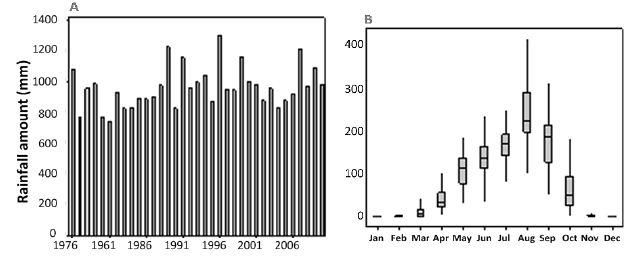
Fig. 2 . Annual rainfall (A) and monthly variation in rainfall (B) of Bolgatanga (1976-2010). Source: Ghana Meteorological Services Department.